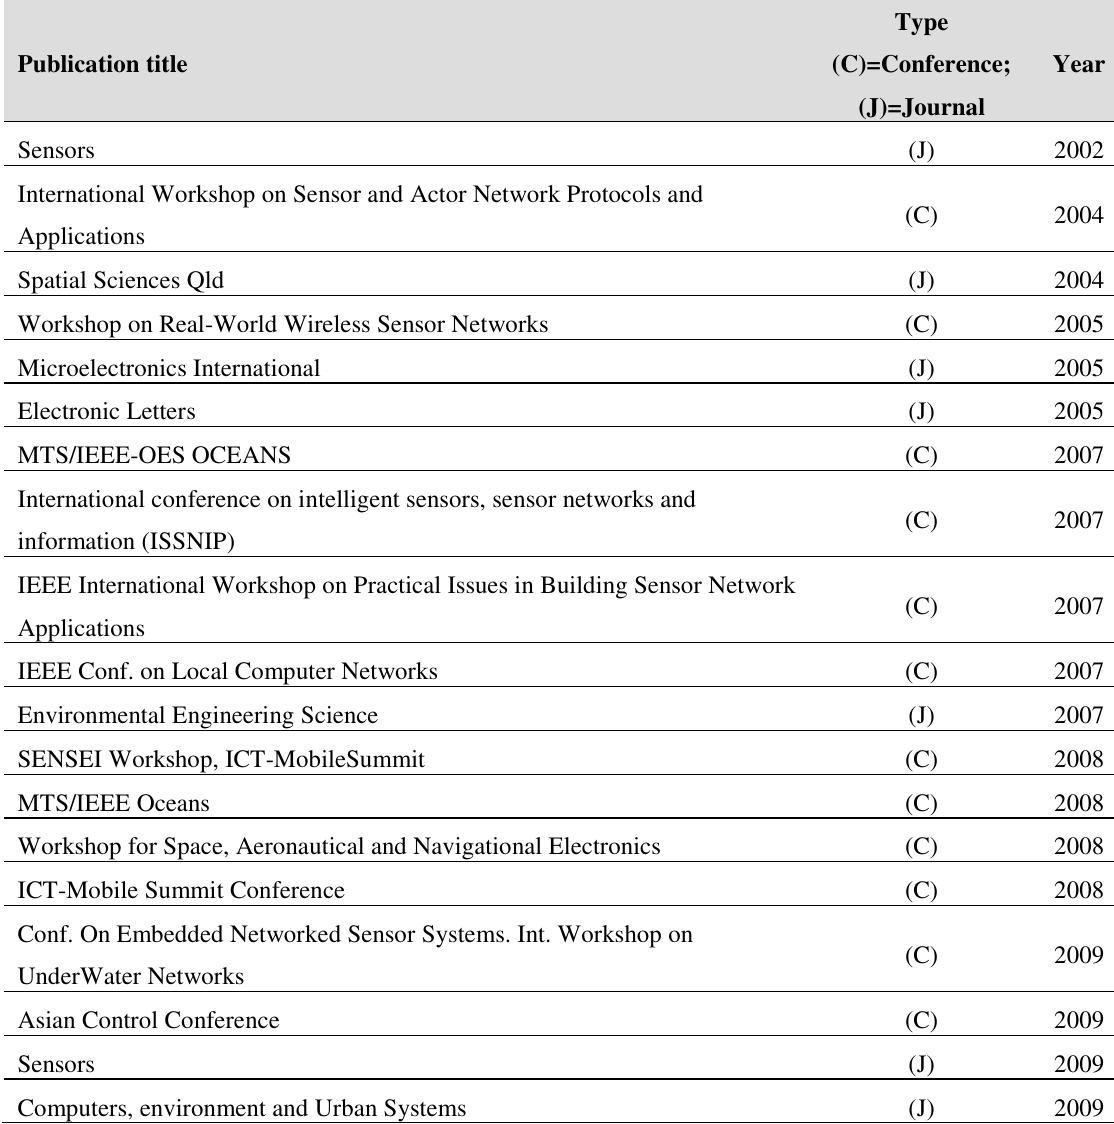
Table 6. List of conferences and journals identified by the